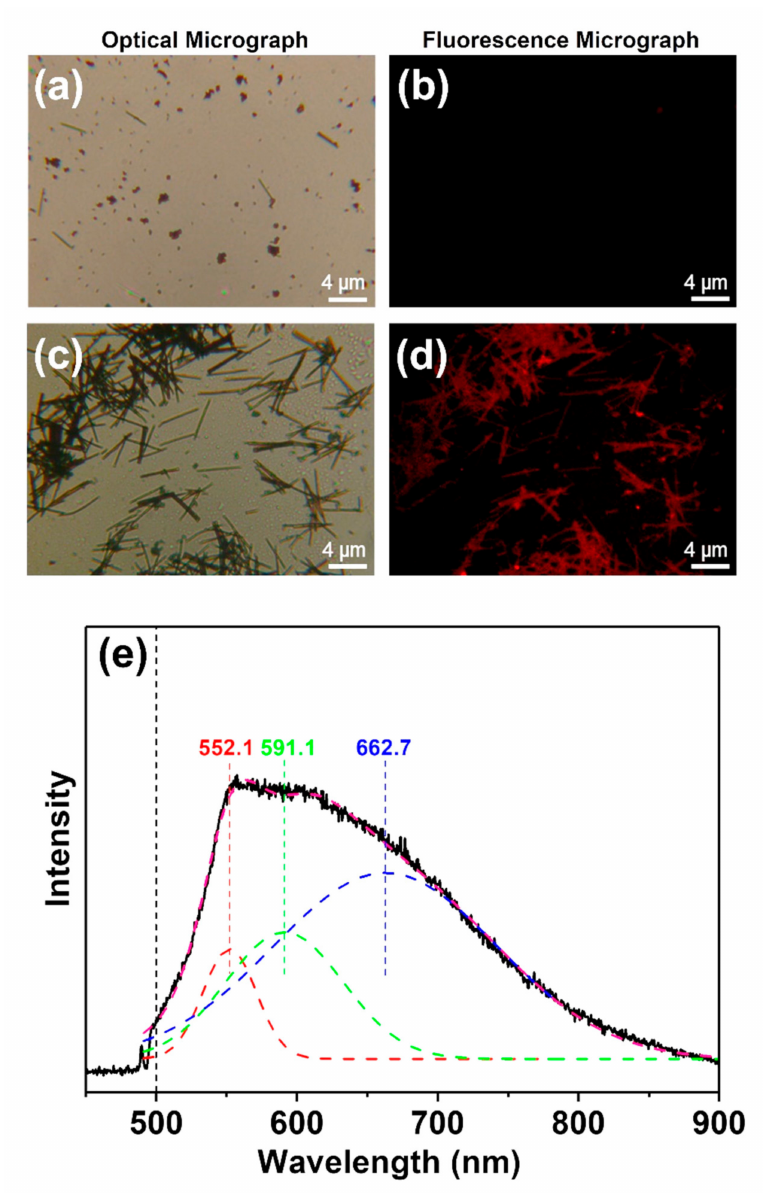
Figure 3. ( a ) An optical micrograph and ( b ) a fluorescence micrograph of the control sample, PPy nanorods without CdSe nanoparticles. No observable photoluminescence was detected for the control sample. ( c , d ) Respective data for CdSe-embedded PPy nanorods where emissions from the hybrid nanorods were captured. ( e ) A photoluminescence spectrum from the CdSe-embedded PPy nanorods (black), deconvoluted peak fittings (red, green, and blue dotted lines), and the cumulative peak fitting